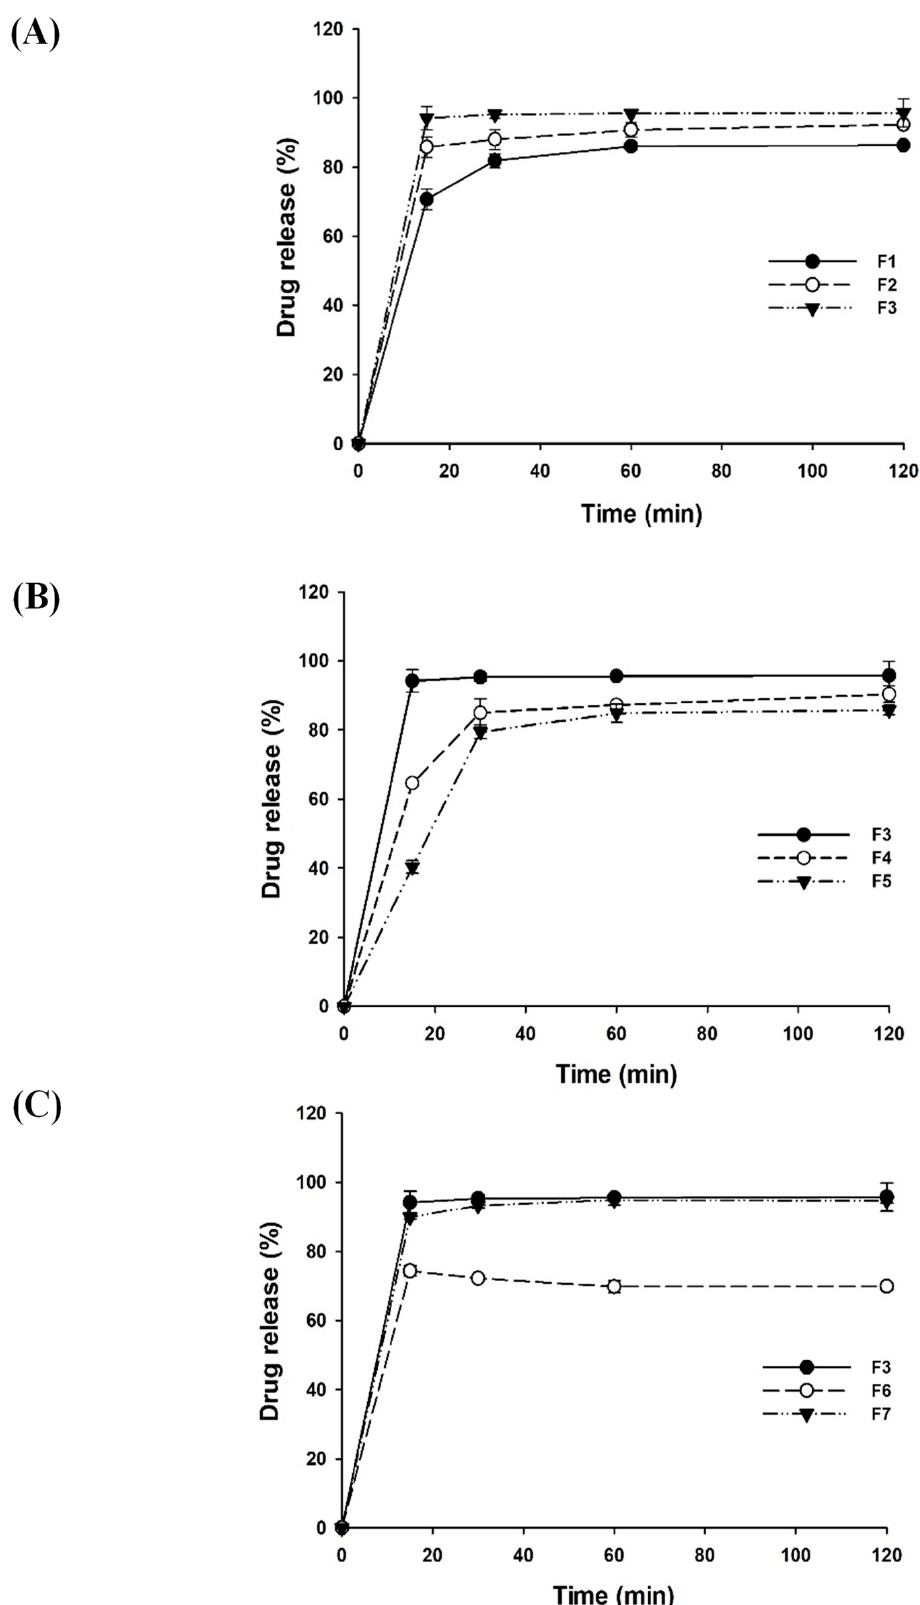
Figure 1. Effect of krill oil ( A ), aminoclay ( B ), and TPGS ( C ) on drug release (Mean ± SD, n = 3).